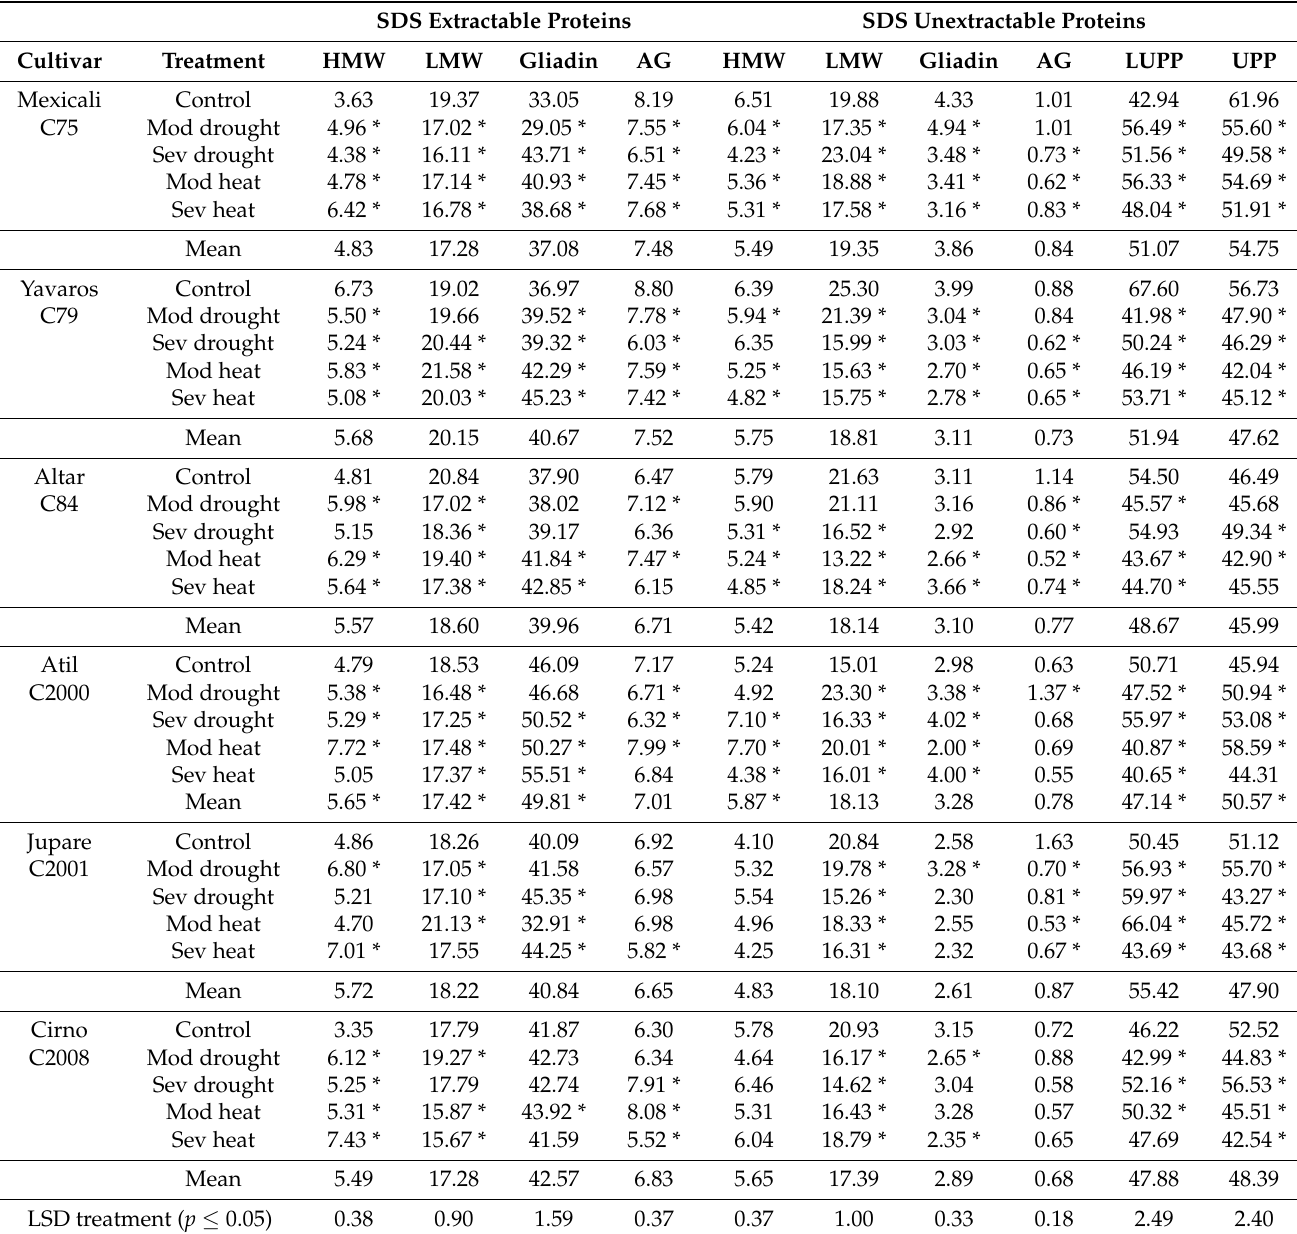
Table 2. SDS extractable and unextractable gluten proteins (%) combined for two seasons. SDS Extractable Proteins SDS Unextractable